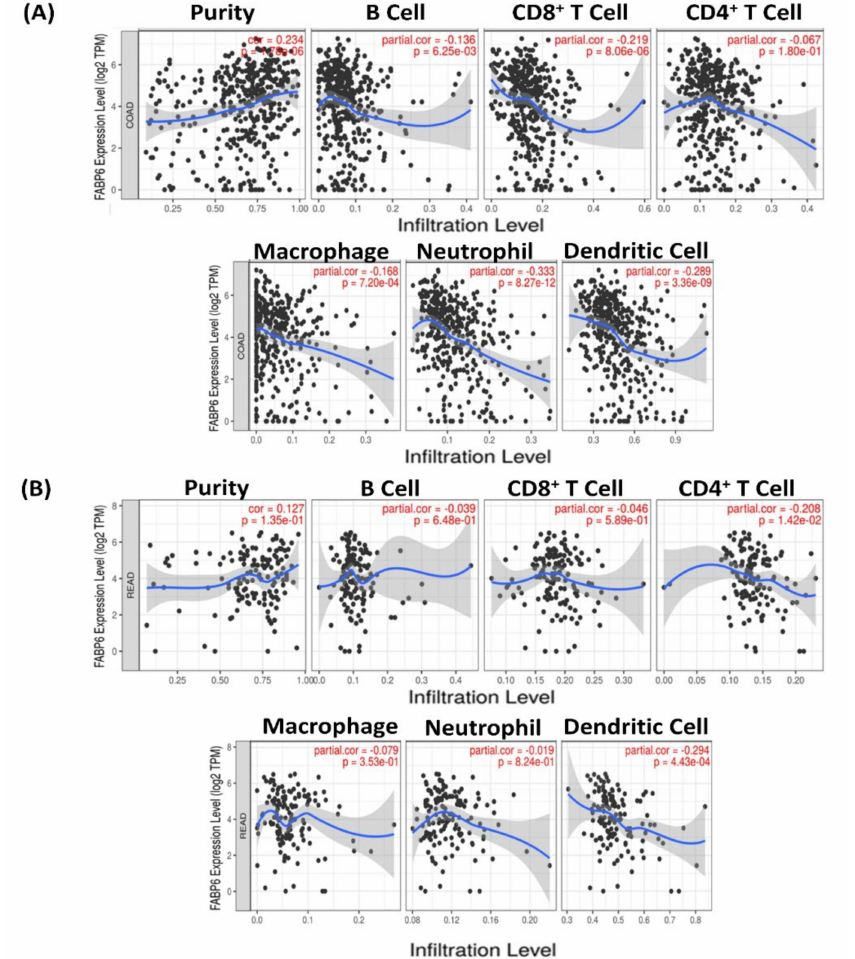
Figure 9. Correlations between differentially expressed fatty acid-binding protein 6 ( FABP6 ) gene and immune cell infiltration in primary ( A ) colon adenocarcinoma (COAD) and ( B ) rectal adenocarcinoma (READ) patients. Analysis of the correlation between FABP6 gene overexpression and some tumor infiltration parameters in both COAD and READ patients was accomplished using TIMER. The figure shows that the FABP6 gene expression was associated with tumor purity and several tumor- infiltrating immune cell markers, such as CD8 + T cells, B cells, CD4 + T cells, neutrophils, macrophages, and dendritic cells. Spearman correlations were applied to describe correlations between FABP family genes and the abovementioned immune cells ( p < 0.05 was accepted as statistically